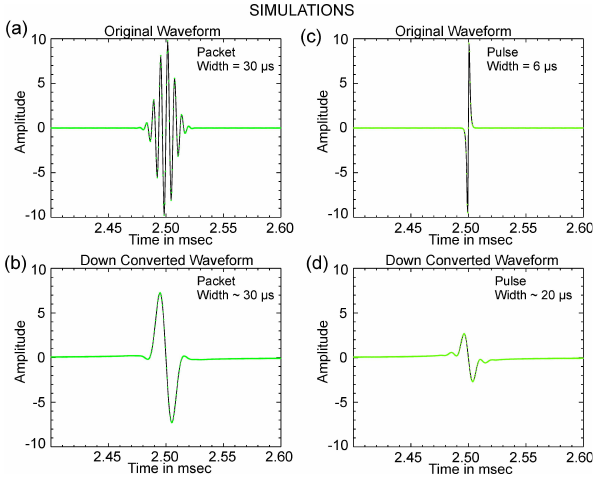
Fig. 3. Simulated waveform data both before and after down con- version from 125kHz using a 77kHz filter bandwidth for two types of input waves. (a) 0.2ms portion of the input waveform consist- ing of a packet of duration 30µs, encapsulating a 162kHz carrier wave. (b) Waveform data from (a) after down conversion, showing the waveform packet as a bipolar type pulse of duration ∼ 30µs. (c) 0.2ms portion of the input waveform consisting of a bipolar pulse of duration 6µs. (d) Waveform data from (c) after down conversion, showing the output as a modified bipolar pulse of duration ∼